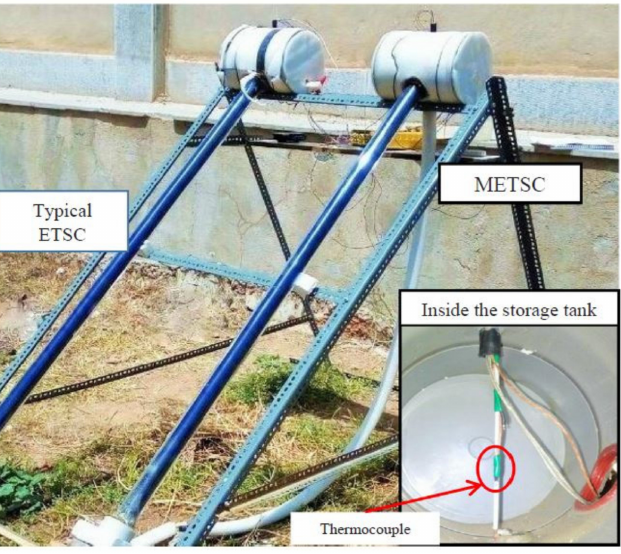
Figure 9. Comparative study of typical ETSC and modified ETS